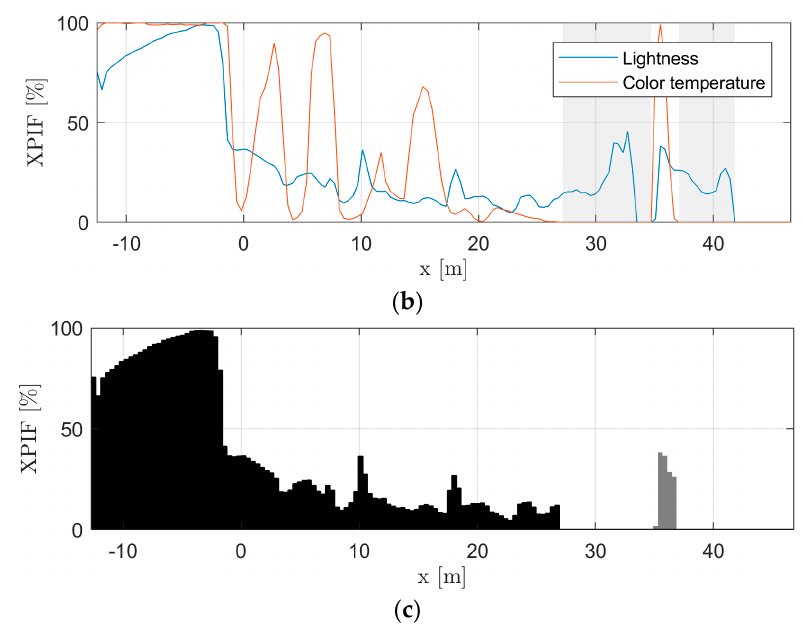
Figure 8. ( a ) Example timestack from transect N2 taken at 12:00 on 23/03/2017 showing intermittent overwashing on the rock platform at this location, ( b ) cross-platform inundation frequency (XPIF) as defined by the pixel lightness metric and the pixel color temperature metric, and ( c ) resultant combined XPIF profile (grey and black bars) with the grey bars removed via automatic quality control processes to obtain the final XPIF profile (black bars). See Figure 2 for transect location.